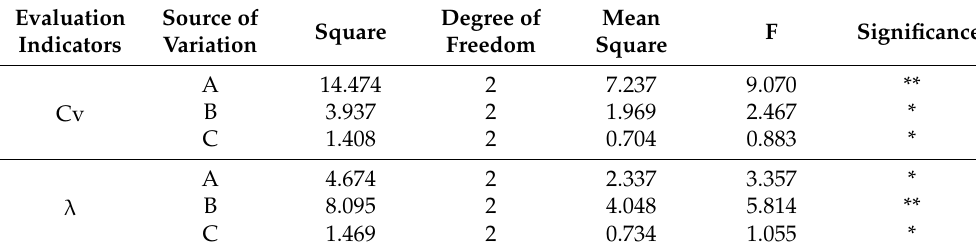
Table 8. Analysis of variance.